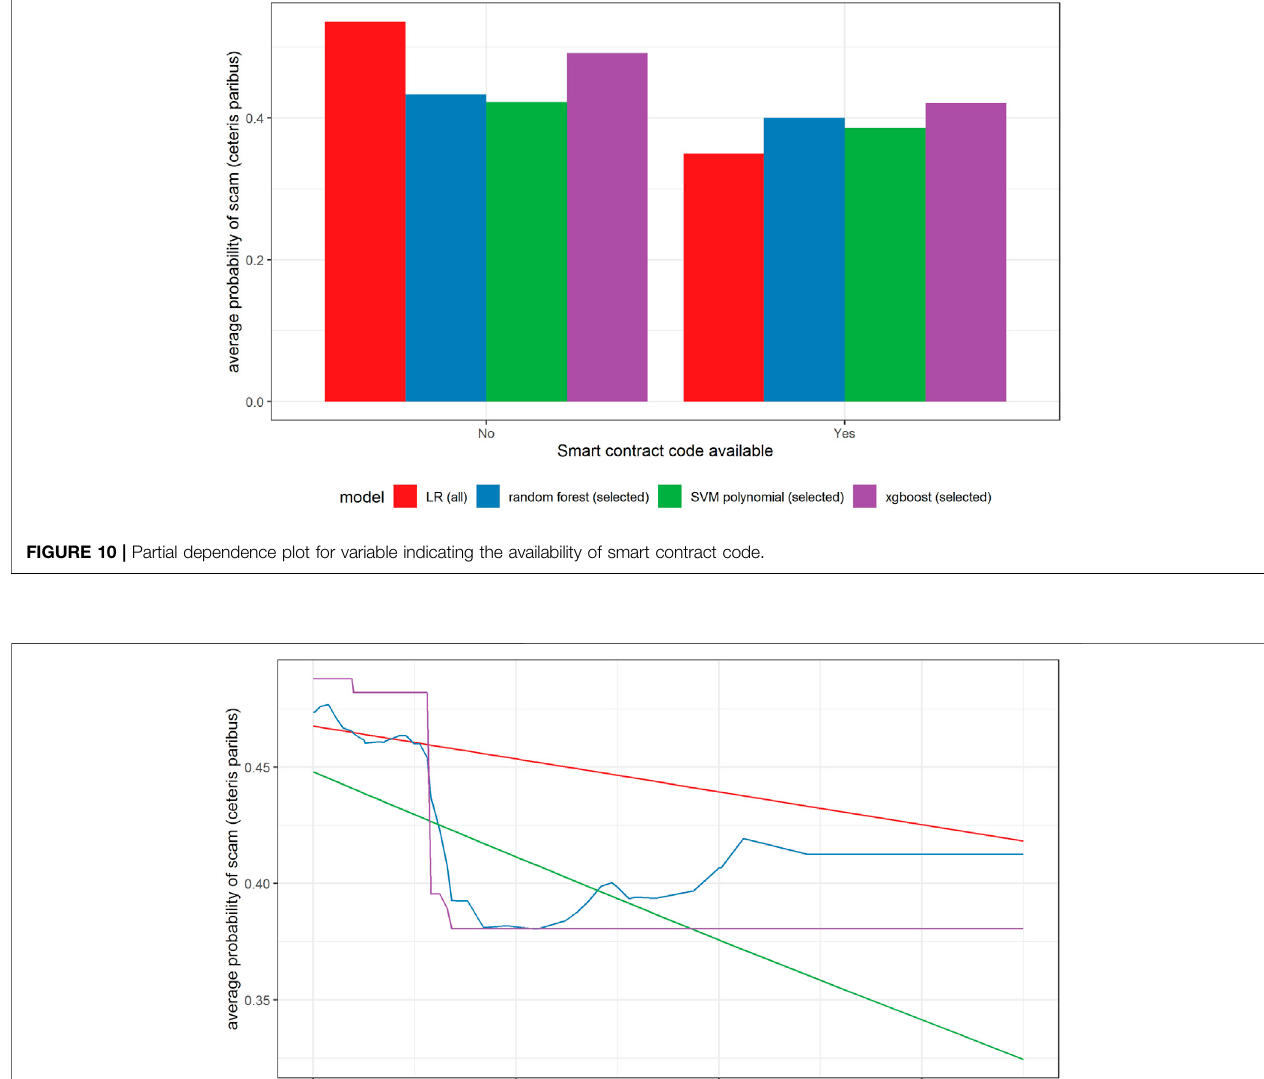
Frontiers in Arti fi cial Intelligence |